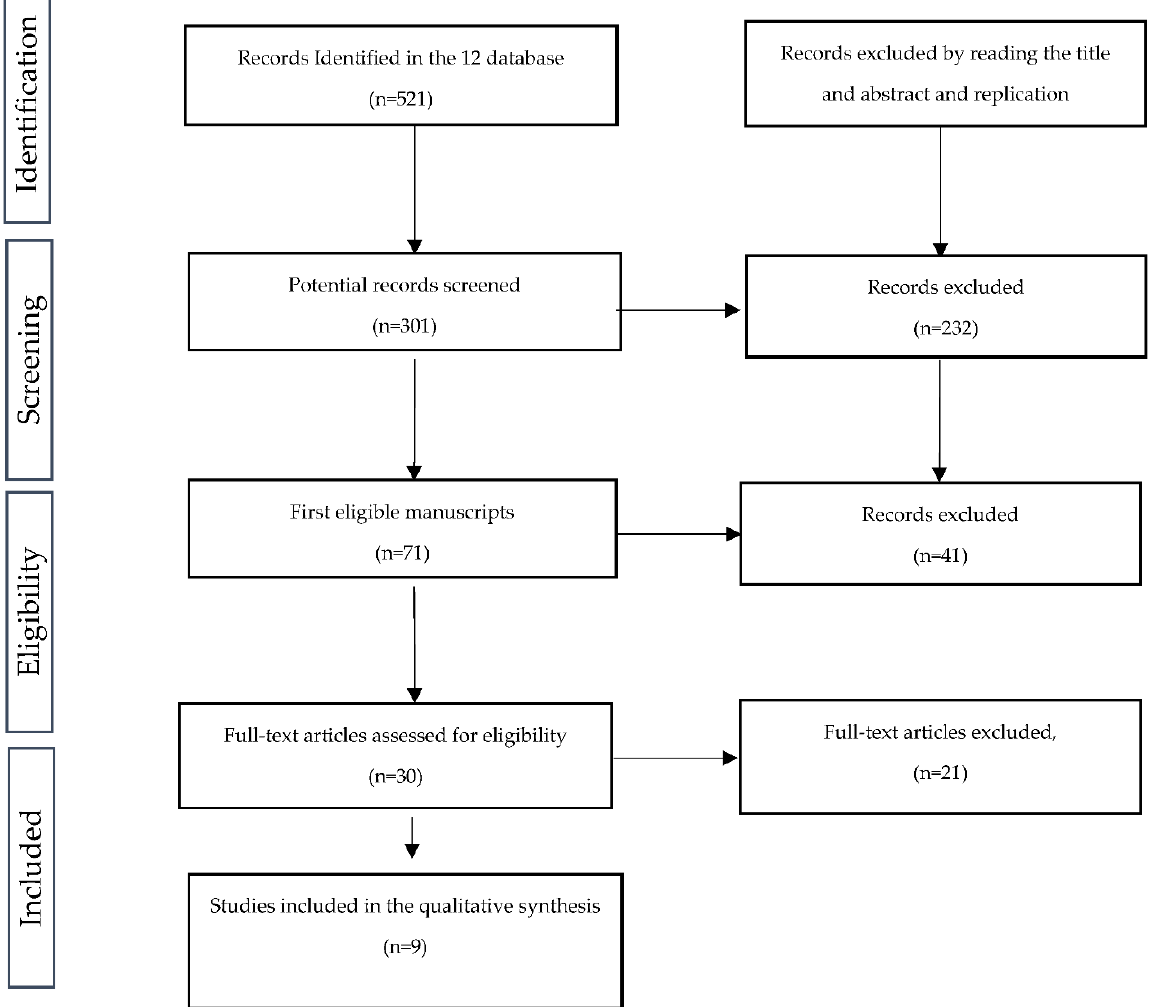
Figure 1. Flowchart of studies included following PRISMA guidelines.